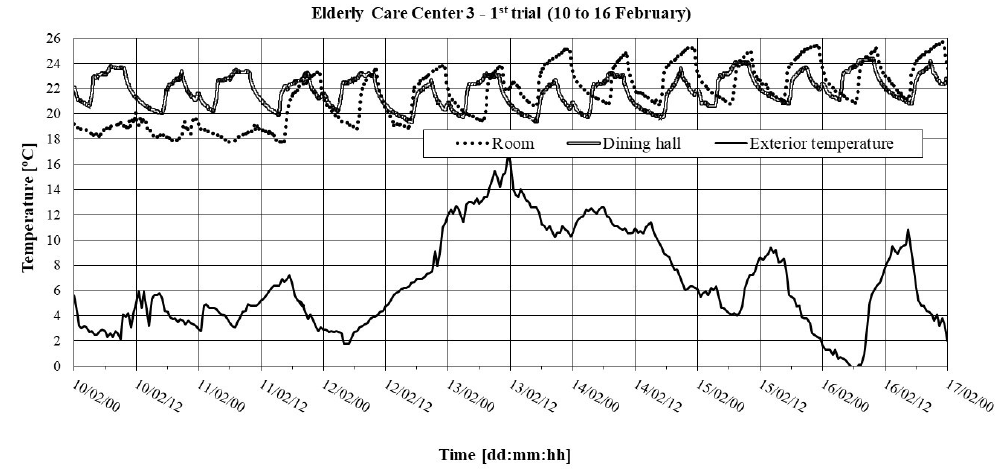
Figure 4. Interior temperature in ECC 3: 1 st trial (10 to 16 February). Table 13. Statistical analysis of hygrothermal parameters recorded in compartments of ECC 3: 1 st trial (February–March).